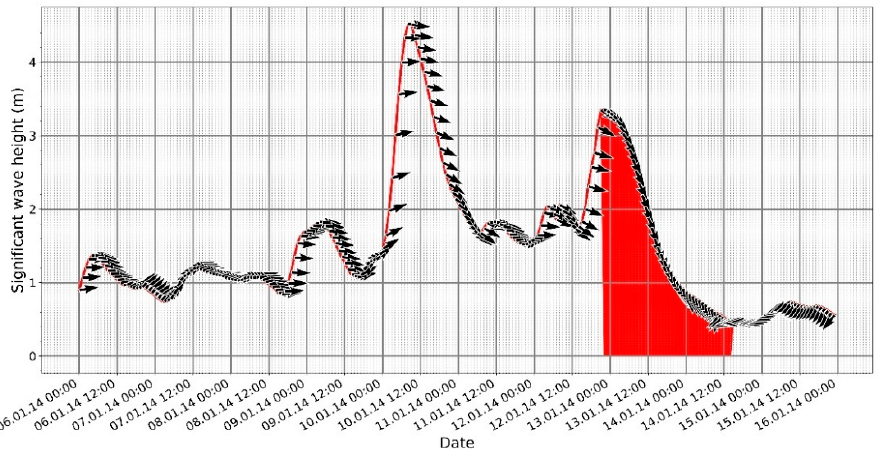
Figure 6. Change in the height (graphs) and direction (arrows) of the significant waves from 6 January 2014 to 16 January 2014.